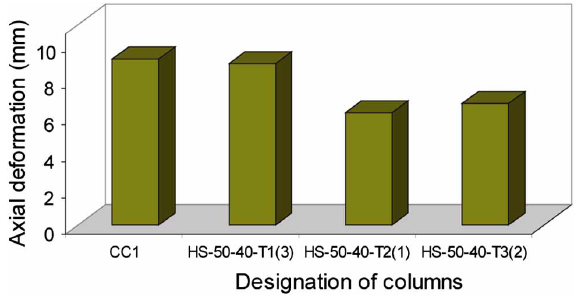
Fig. 15. Axial deformation of columns HS-50-40 (cid:1) comparison